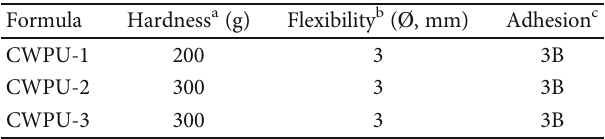
Table 5: Mechanical properties of cationic waterborne polyurethane (CWPU) fi lms with various internal emulsi fi er